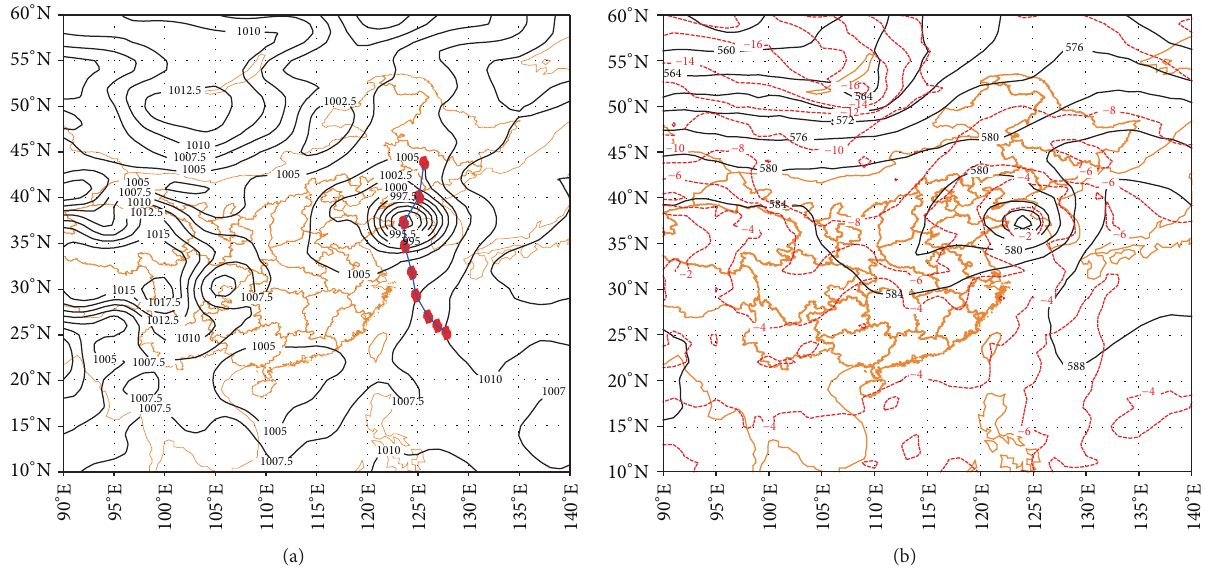
Figure 2: Surface weather map at 08BJT on August 8th along with typhoon mark symbol every 12 hours on the drawing from south at 08BJT on August 5th to north at 08BJT on August 9th of 2011 (a) and 500hPa temperature (red line) and geopotential height (black line) at 08BJT on August 8th of 2011